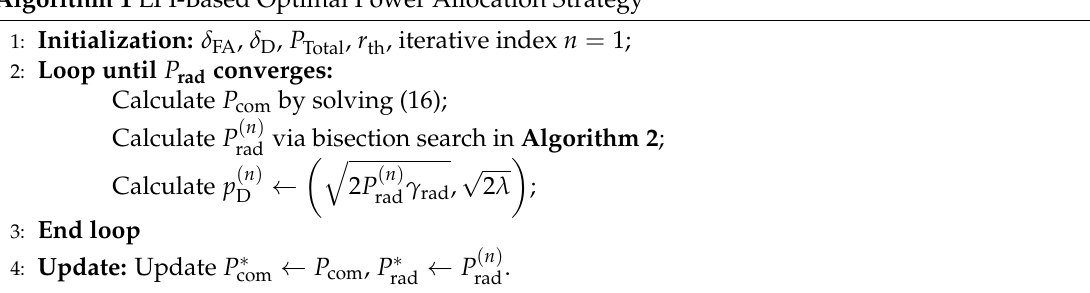
Algorithm 1 LPI-Based Optimal Power Allocation